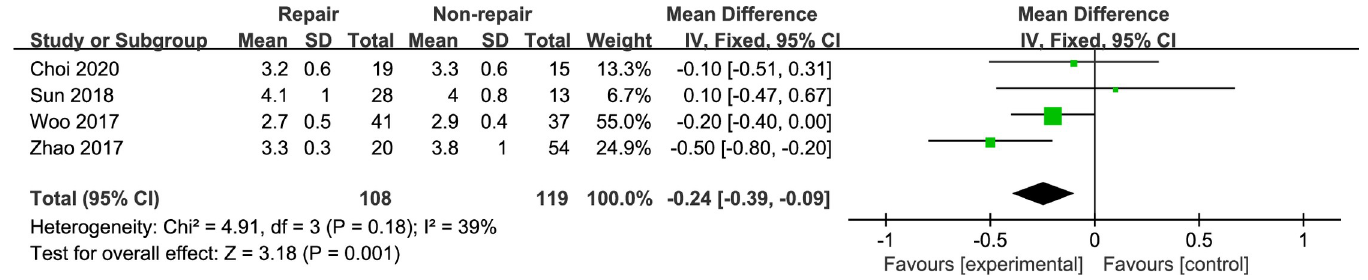
Fig 4. The forest plot of post-operative